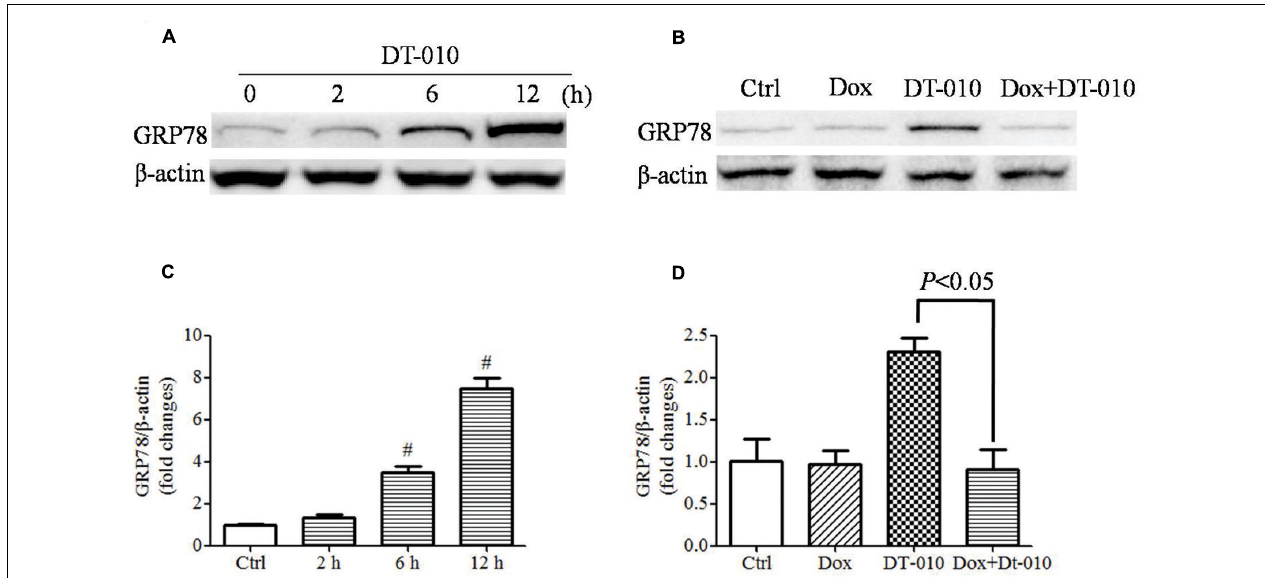
FIGURE 4 | Dox inhibited DT-010-induced GRP78 expression in MCF-7 cells. Immunoblots (A) and densitometric analysis (C) of the expression of GRP78 protein were determined after DT-010 treatment in MCF-7 cells. (B) MCF-7 cells were treated with DT-010 for 24 h in the presence or absence of Dox. Representative immunoblots for the expression of GRP78 and β -actin proteins were exhibited. (D) Densitometric analysis showed the expression of GRP78 protein. # P < 0.05 vs.